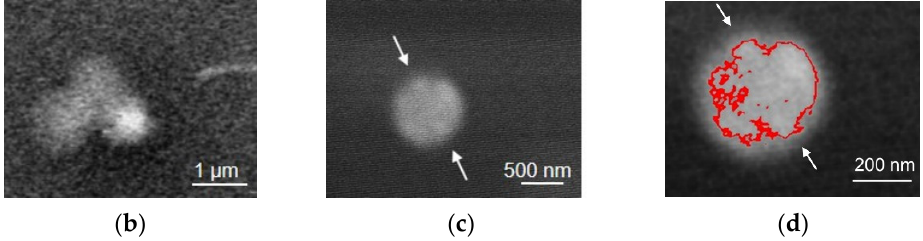
Figure 9. Images of cyanobacteria in liquid using the microfluidic liquid cell with the super-thin ETM. ( a ) Bright-field optical microscope image of cyanobacteria in liquid. ( b ) SEM image of bacterium in liquid through an 80-nm-thick ETM. ( c ) SEM image of bacterium in liquid through a super-thin ETM. It has microstructures (white arrows). ( d ) Outline of bacterium in processed SEM image.